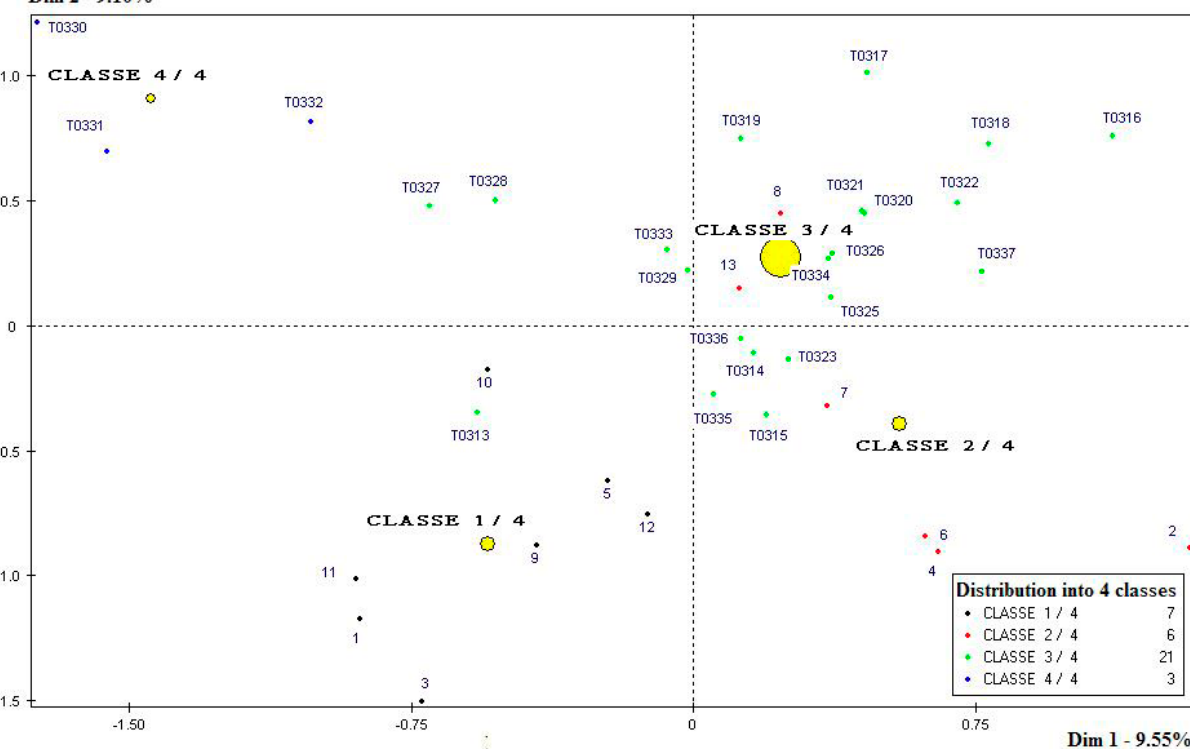
Figure 1. HAC of the 2005-2006 populations of Mycosphaerella graminicol a for the county 56 (Morbihan). T0313 to T0337 are the strains collected in 2005. The 2006 strains are represented by numbers 1 to 13. Strains are distributed in four classes. The centre of each class is defined by a